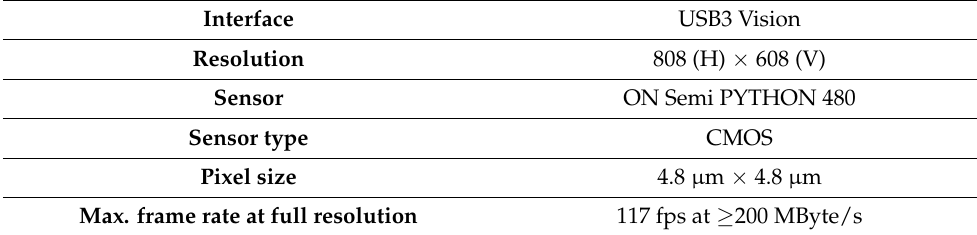
Figure 1. Alvium 1800 U-050 industrial camera. Table 1. Alvium 1800 U-050 specifications.